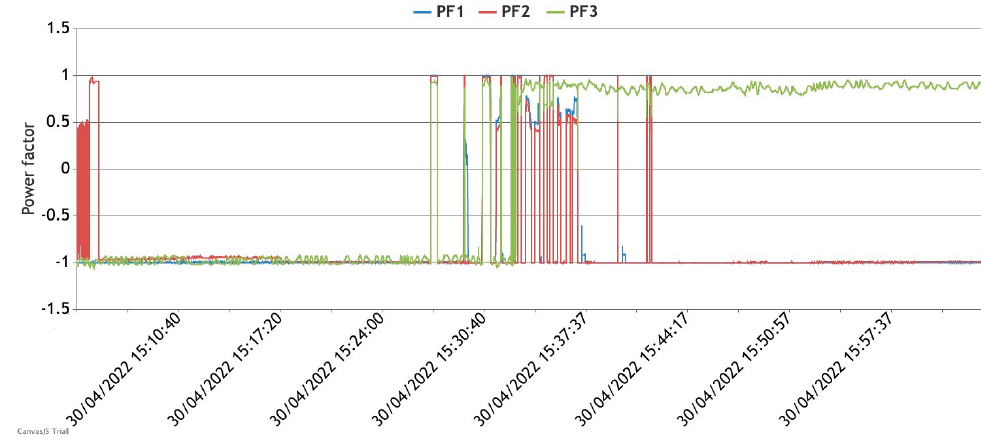
Figure 10. Calculated each phase power factor PF1, PF2, PF3 at the grid connection point.